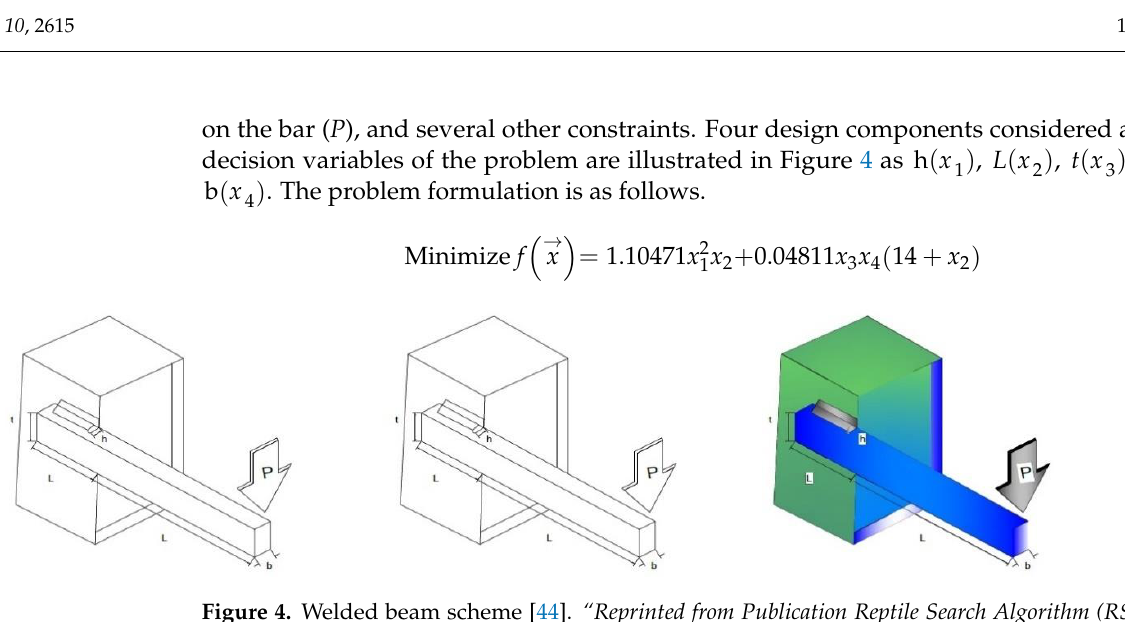
Figure 4. Welded beam scheme [44]. "Reprinted from Publication Reptile Search Algorithm (RSA): A nature-inspired meta-heuristic optimizer, vol. 191, 1 – 32, Copyright (2022), with permission from Elsevier."